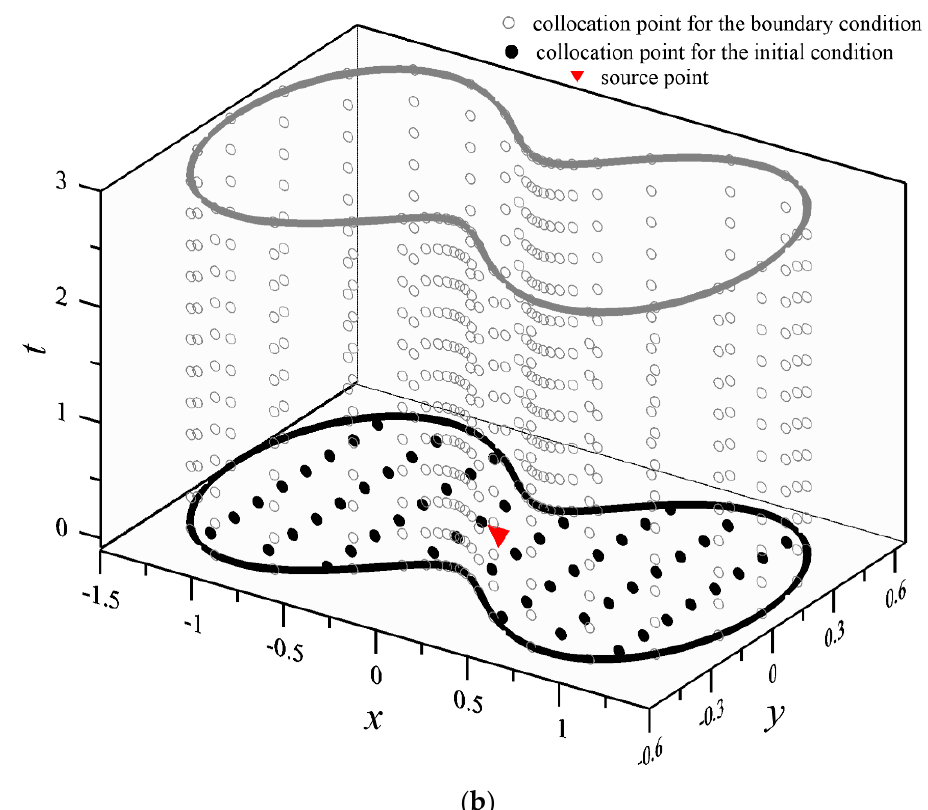
Figure 1. The original Euclidean space domain and the space–time collocation scheme: ( a ) The Euclidean space domain; ( b ) The space–time scheme.